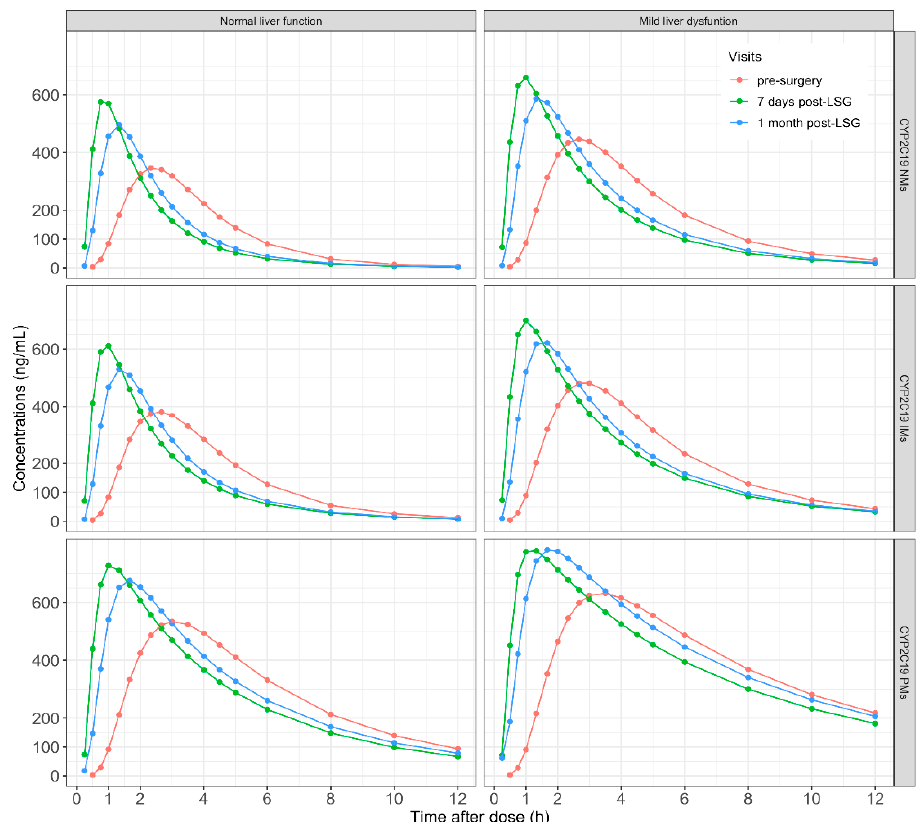
Figure 3. Mean concentration–time curves of omeprazole based on 1000 simulations stratified by liver function and CYP2C19 genotype in obese patients undergoing LSG.